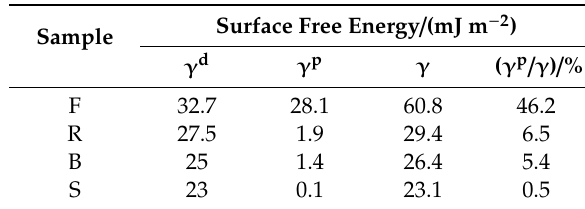
Table 4. Surface free energies of papers determined by Owens, Wendt, Rabel, and Kaelble (OWRK) method; ( γ p / γ )–index of